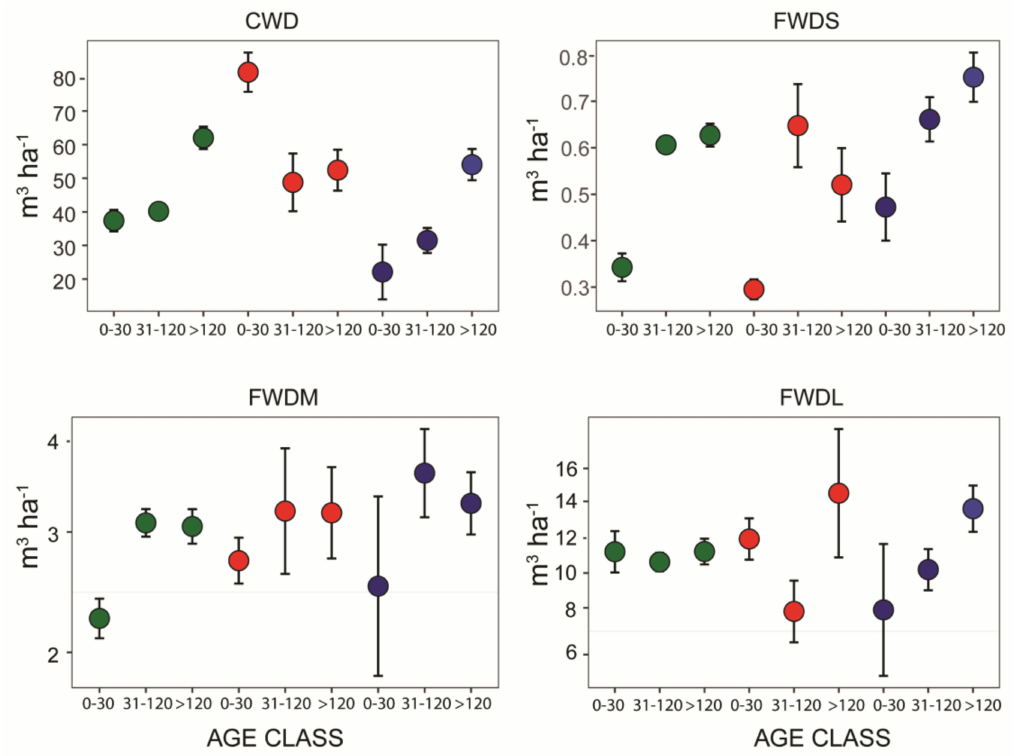
Figure 6. Mean volume and standard error values of coarse woody debris (CWD), fine woody debris size classes small (FWDS), medium (FWDM), and large (FWDL), for stand disturbance types no major disturbance (NMD) (green dots), fire (red dots), and insects (blue dots), separated by stand development age classes for each disturbance